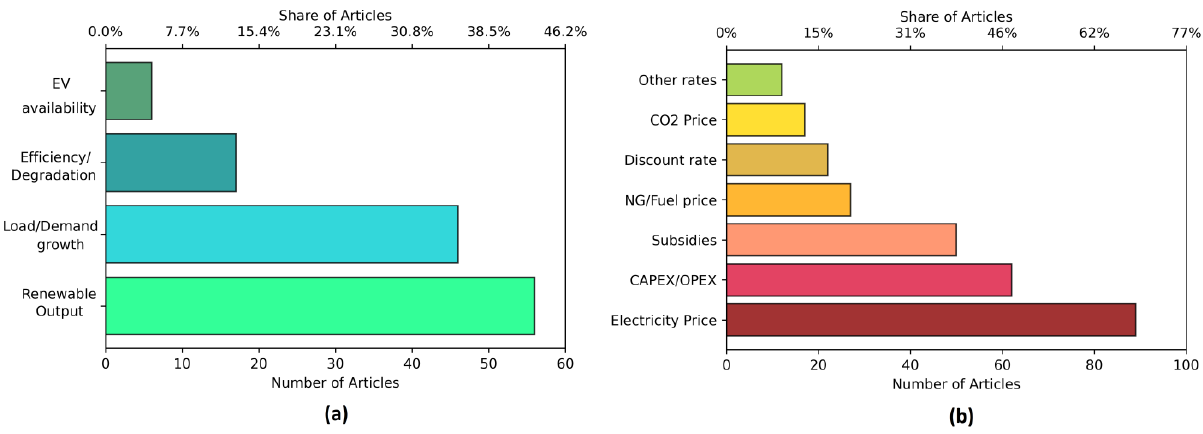
Figure 4. Number and share of articles in the pool that consider each source of physical uncertainty ( a ) and E&R uncertainty ( b ). Each article considers one or more E&R uncertainty but may not consider any physical